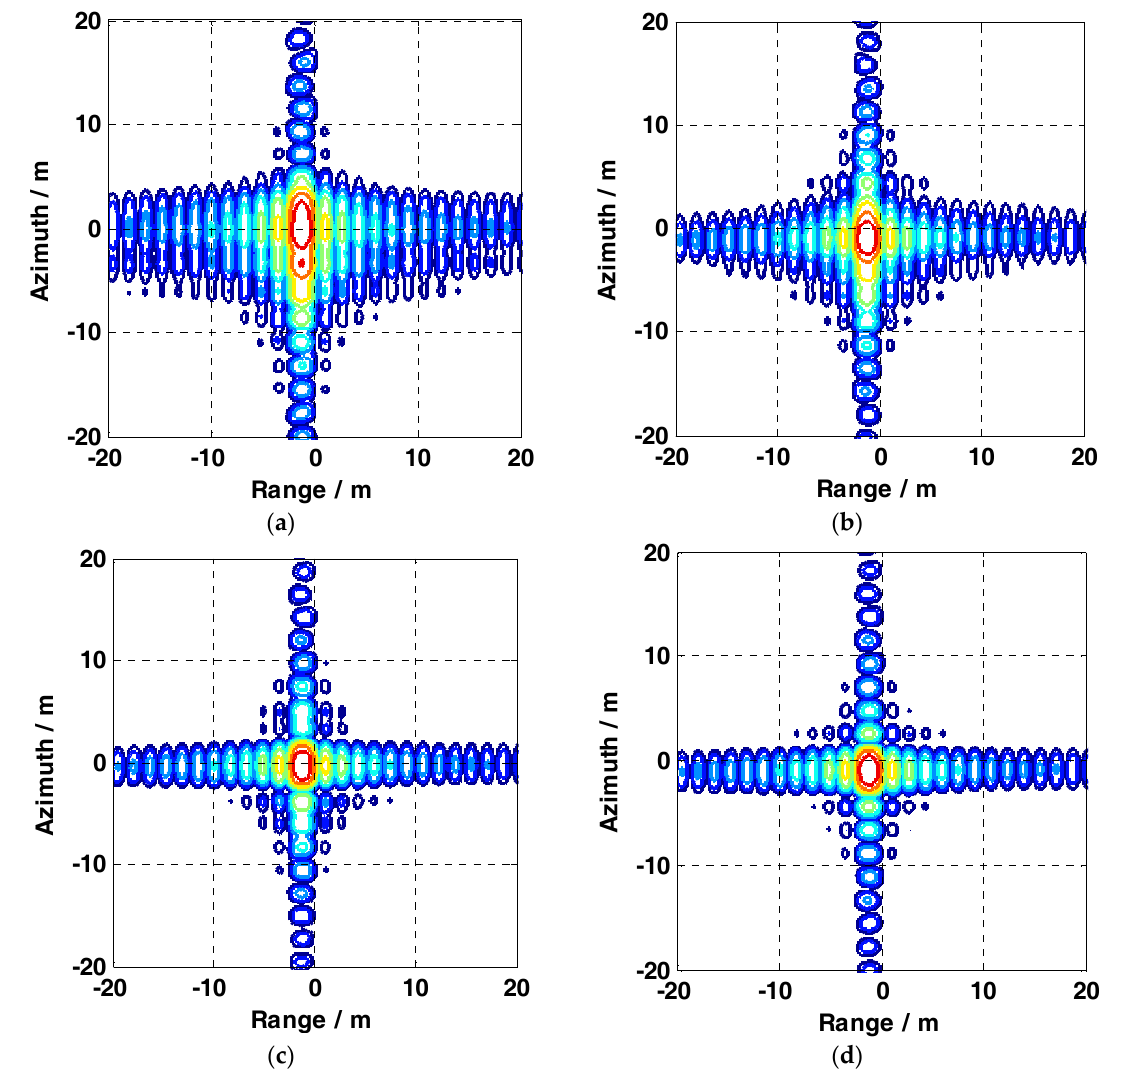
Figure 9. Target 5’s contours processed by ( a ) the conventional SAR imaging algorithm (CS algorithm), ( b ) MD algorithm, ( c ) PGA algorithm, and ( d ) BLUE algorithm, for SAR data with mild accelerated motion error.